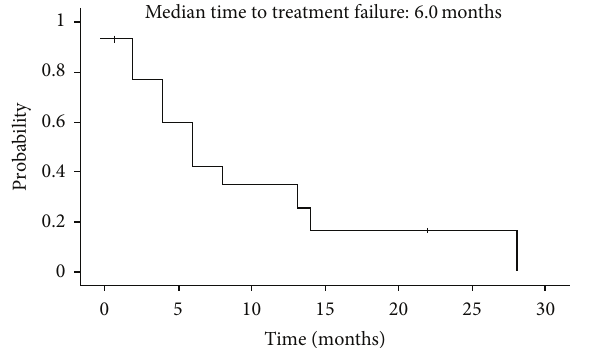
Figure 1: Time to treatment failure in all enrolled patients. Median time to treatment failure was 6.0 months.